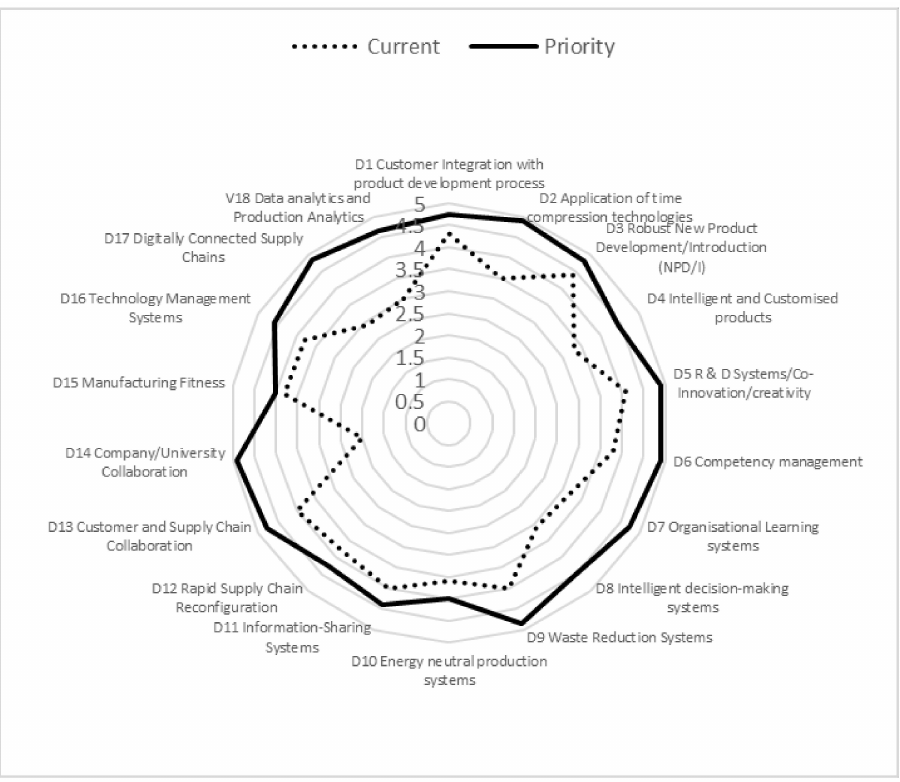
Figure 3. The analysis of current and future profiles of SMEs with 10–50